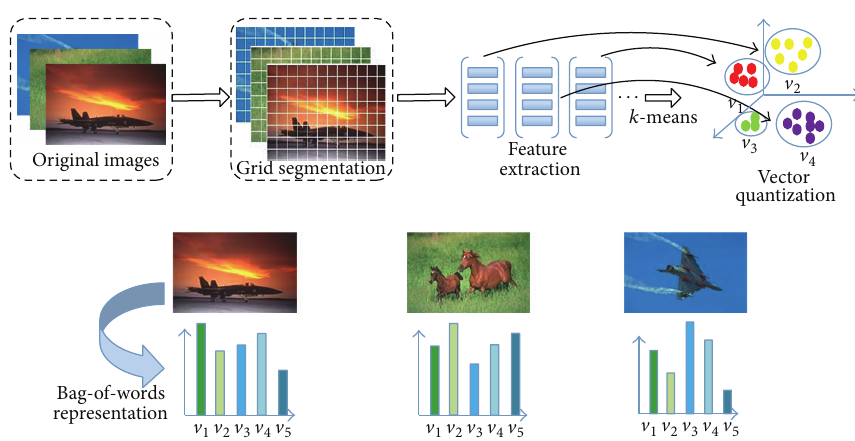
Figure 2: The flow chart of getting BoW representation of the image low-level feature.